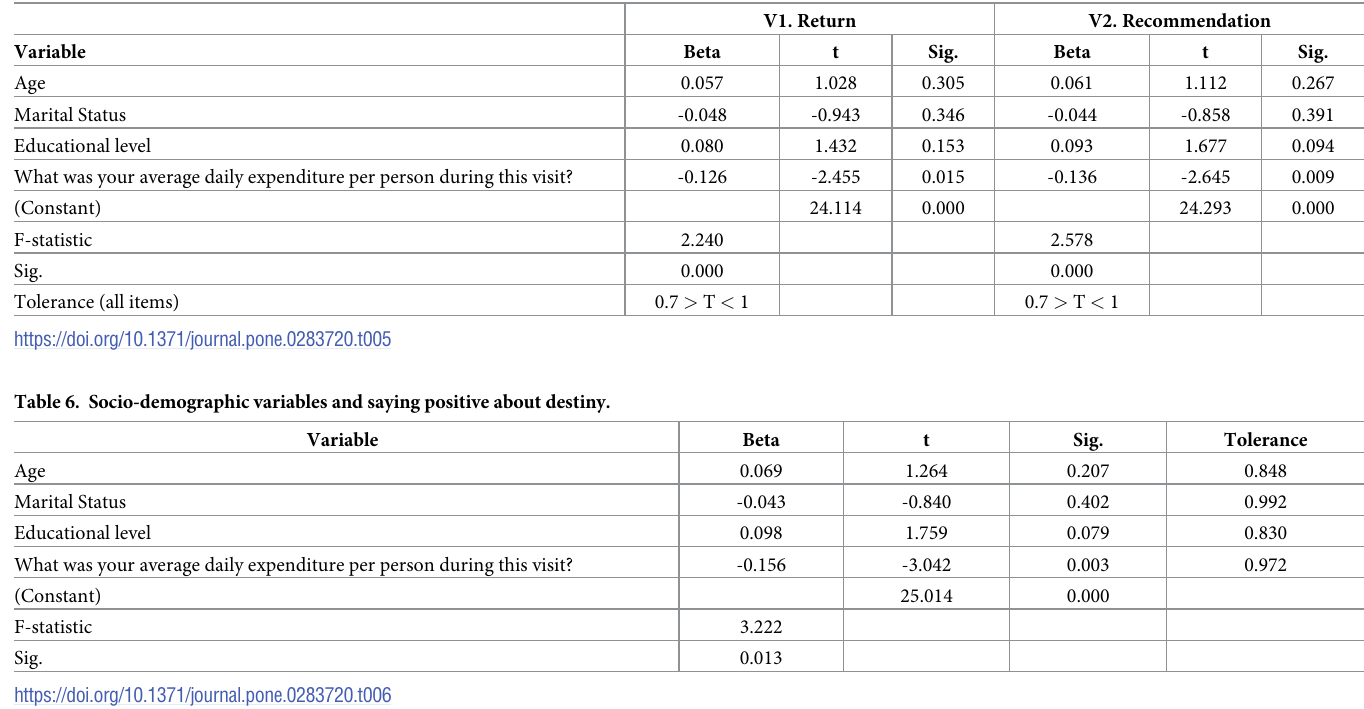
Table 5. Socio-demographic variables and return and recommendation intentions.